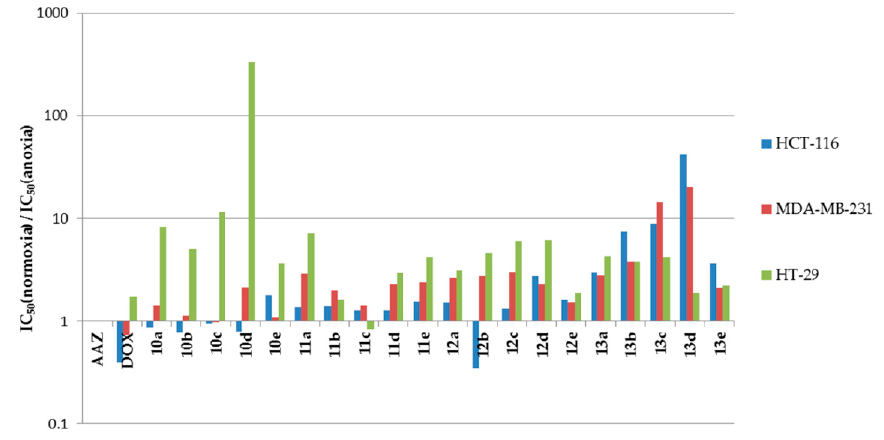
Figure 4. The cytotoxic activities of anoxia condition compared with normoxia codition.